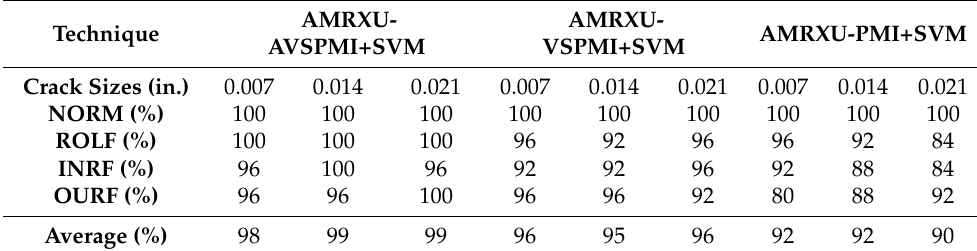
Table 9. The average accuracy in fault pattern identification from the proposed AMRXU- AVSPMI+SVM compared to AMRXU-VSPMI+SVM and AMRXU-PMI+SVM.